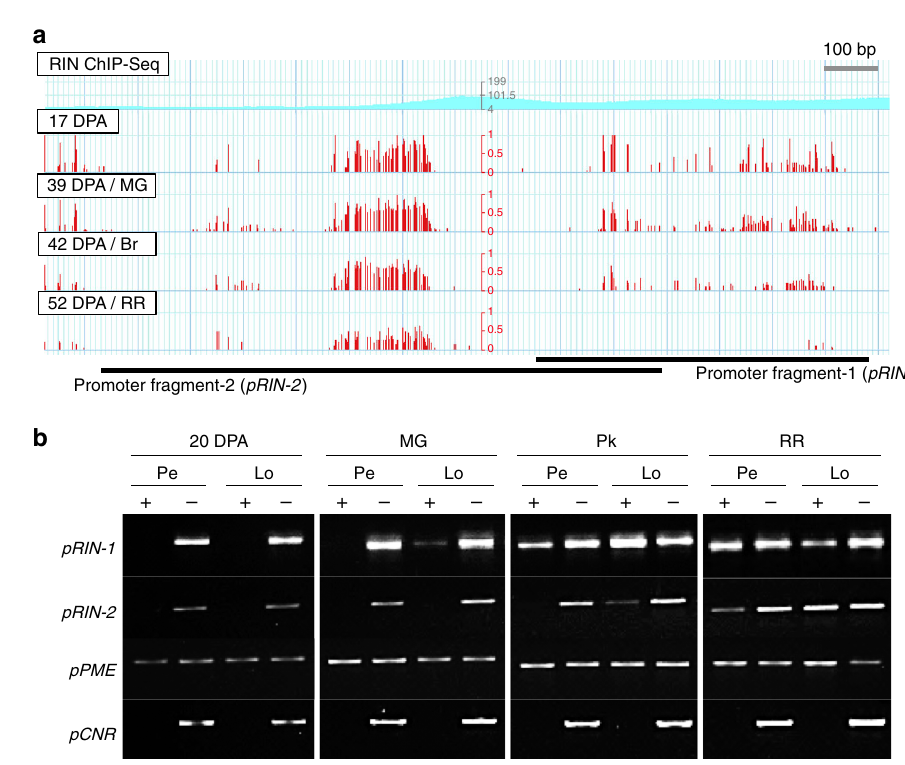
Fig. 6 Differential ripening-related demethylation of the promoter of RIN between pericarp and locular tissue. a RIN self-binding sites and differentially methylated regions in the RIN promoter, based on analyses of pericarp samples (available at ted.bti.cornell.edu/epigenome). ChIP-seq plot depicts position of RIN binding, with peak height representing the number of reads covering each site (i.e., read depth). Red bars indicate cytosine methylation ratios at the equivalent position. Two promoter fragments analyzed by McrBC-PCR are indicated by black bars. b McrBC-PCR analysis of two RIN promoter fragments in pericarp (Pe) and locular tissue (Lo) at four stages spanning fruit expansion and ripening. A total of 0.5 μ g genomic DNA was digested by McrBC (NEB) with GTP (+), or without GTP ( − ) as a negative control. An unmethylated region of the PME (Solyc03g123630) promoter is included as a positive control, and a highly methylated region of the CNR (Solyc02g077920) promoter showing complete digestion of methylated DNA. DPA, days post-anthesis; MG, mature green; Br, breaker; Pk, pink; RR, red